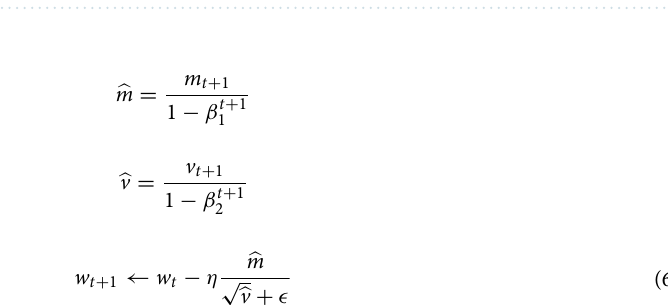
Table 1. Number of samples and their weights in the training